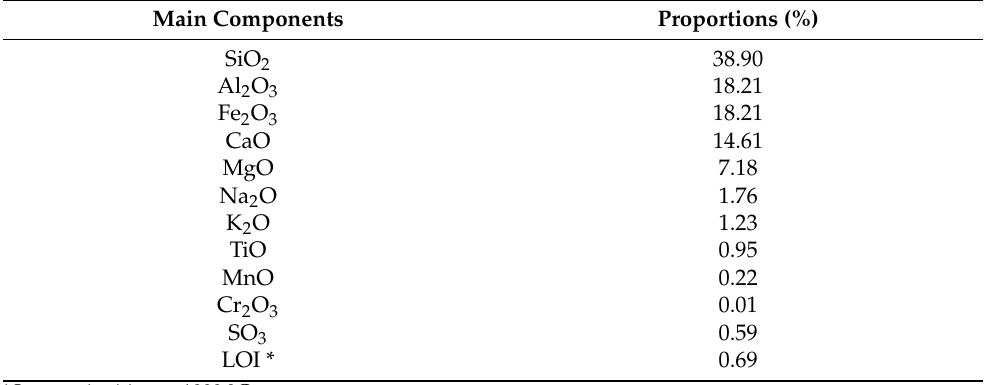
Table 1. The chemical component of fly ash (by mass ratio) [19].